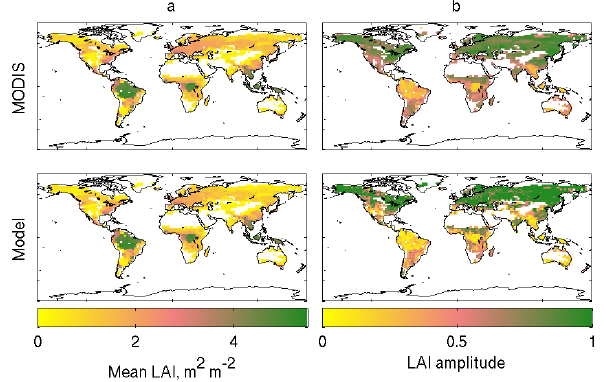
Fig. 3. Predicted (black) and observed (blue) LAI for (a) tropical wet forests (6 ◦ S, 55 ◦ W), (b) tropical dry forests (14 ◦ S, 20 ◦ E), (c) temperate deciduous (46 ◦ N, 15 ◦ E) and (d) temperate evergreen (54 ◦ N, 120 ◦ E). Gray shaded area represents 95% confidence inter- vals calculated from the parameter posterior distribution. The blue shaded area (2006) represents the model evaluation